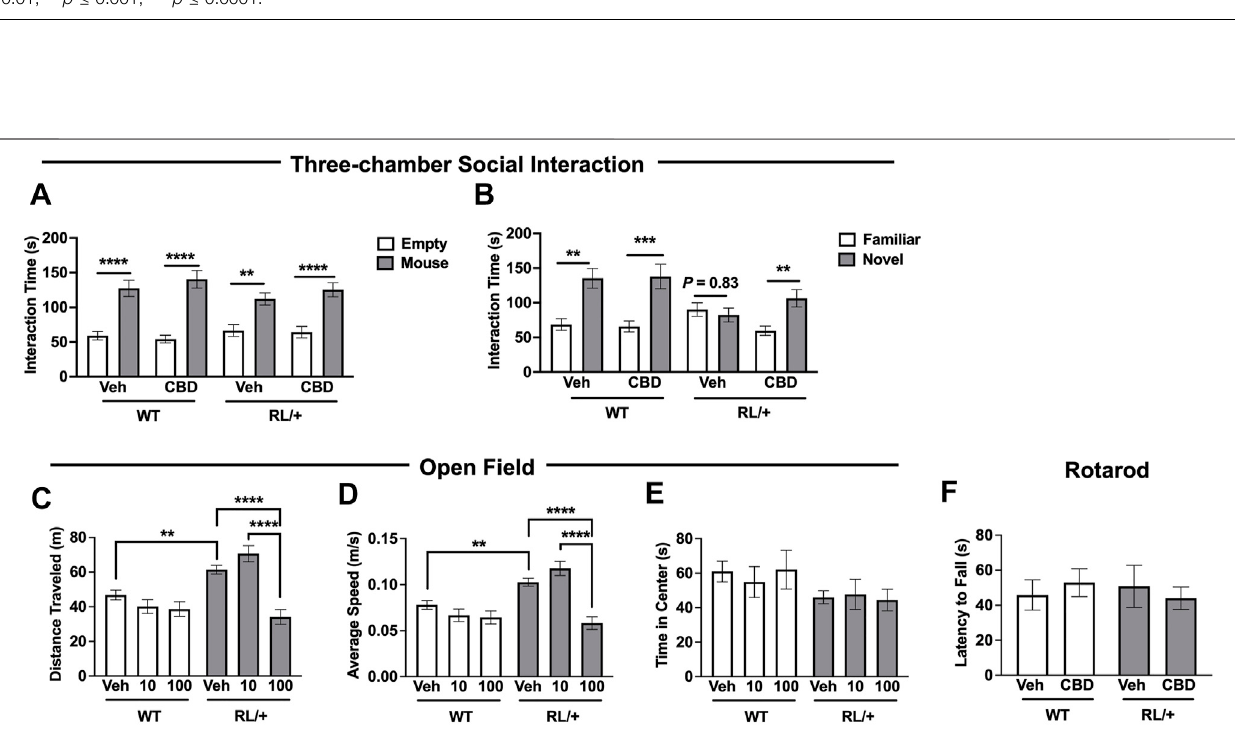
Frontiers in Pharmacology |